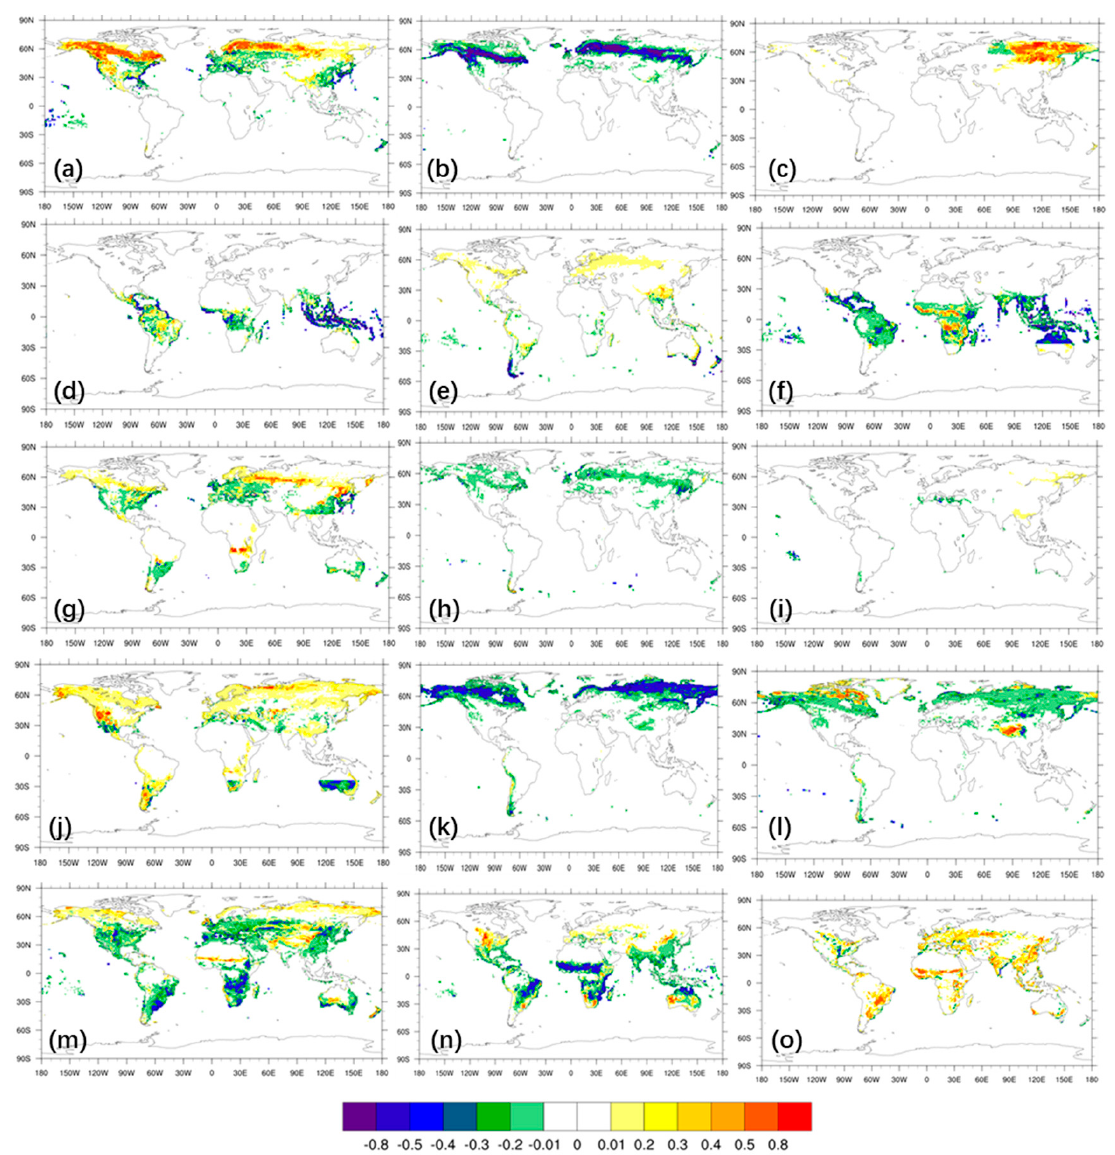
Figure 1. The difference in grid proportion for different PFTs (ESACCI–CLM_LS): ( a ) NET–temperate; ( b ) NET–boreal; ( c ) NDT–boreal; ( d ) BET–tropical; ( e ) BET–temperate; ( f ) BDT–tropical; ( g ) BDT–temperate; ( h ) BDT–boreal; ( i ) BES–temperate; ( j ) BDS–temperate; ( k ) BDS–boreal; ( l ) C3 arctic grass; ( m ) C3 grass; ( n ) C4 grass; ( o ) Crop.